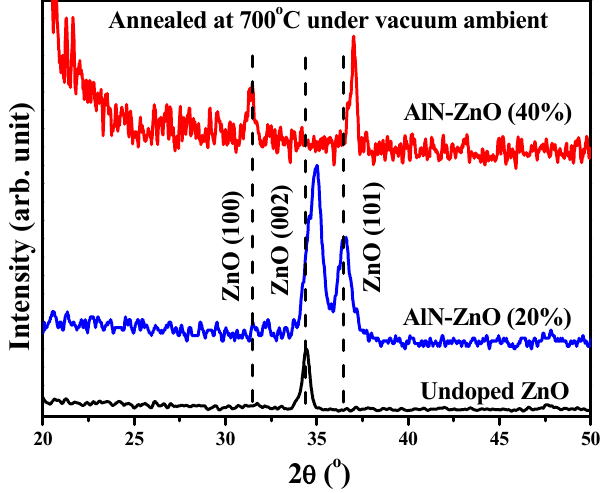
Figure 4. XRD patterns of the undoped ZnO films and cosputtered AlN-ZnO films with Al atomic ratios of 20% and 40%, respectively, after annealing at 700 ◦ C under vacuum ambient for 30 min. The XRD pattern of the annealed undoped ZnO film showed only one peak approximately at 34.46° (assigned as ZnO (002) phase according to JCPDS no.36-1451), revealing the preferred growth orientation along the c -axis. Compared to the undoped ZnO film, the full width at half maximum (FWHM) of the ZnO (002) peak was widened and another peak at about 36.62° (identified as ZnO (101)) was observed from the XRD pattern of the annealed AlN-ZnO (20%) film. This implied that the introduction of the AlN into the ZnO film would break the c -axis growth orientation. In addition,